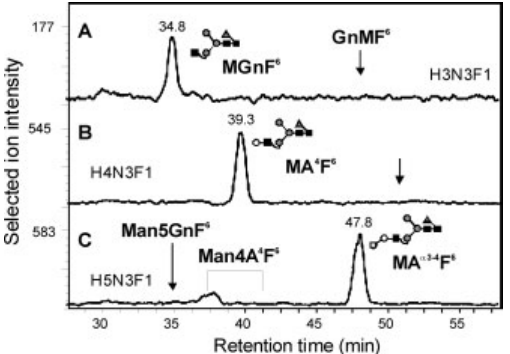
Figure 9. Detail from the oligosaccharide analysis of Daclizumab (Zenapax): Structural assignment of hybrid-type N -glycans. (A) The SIM trace of MGnF 6 /GnMF 6 (structures 32 , 33 ), where one peak appeared at the position of MGnF 6 (and not at that of GnMF 6 , which both were enzymatically generated from GnGnF 6 ). (B) The SIM trace for the mass of MA 4 F 6 /A 4 MF 6 (and theoretically Man4GnF 6 = structure 38 2 Man 1 Gal) showing, again only one of the isomers obtained by N -acetylglucosaminidase digestion of an A 4 GnF 6 /GnA 4 F 6 mixture (structures 2 and 3 ). The arrows in A